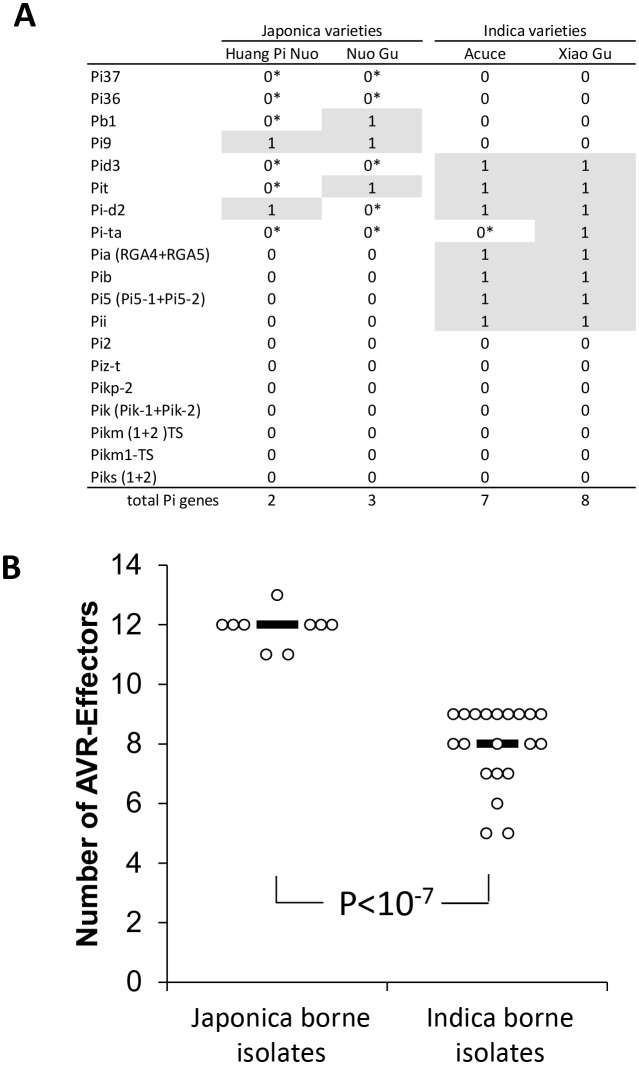
Evaluation of rice Pi and blast Avr-effectors genes in Yuanyang rice varieties and M. oryzae isolates.(A) Presence (1)/absence (0) of 19 cloned Pi gene based on sequence analysis. Pair-end reads from the four varieties were produced (53 to 58 million reads) by whole-genome sequencing. The reads (~150 nucleotides) were mapped on the corresponding Pi sequences using SOAPaligner (http://soap.genomics.org.cn/soapaligner.html) and two mismatches were allowed. Some genes (noted 0*) were present but contained a premature stop codon or were not functional according to inoculation tests (Figure 2—figure supplement 2). The sequences used are listed in Figure 2—figure supplement 1. Note that when two genes are required for resistance (Pia, Pi5, Pik, Pik-s and Pik-m), the sequences of both genes were analyzed. (B) The number of Avr function of 14 effectors was measured (Figure 2—figure supplement 4) in the JB and IB groups of 30 isolates defined in Figure 1C. Each dot represents an isolate and the median (black bar) is indicated. The average values between JB and IB isolates are significantly different (p<10−7; t-test).